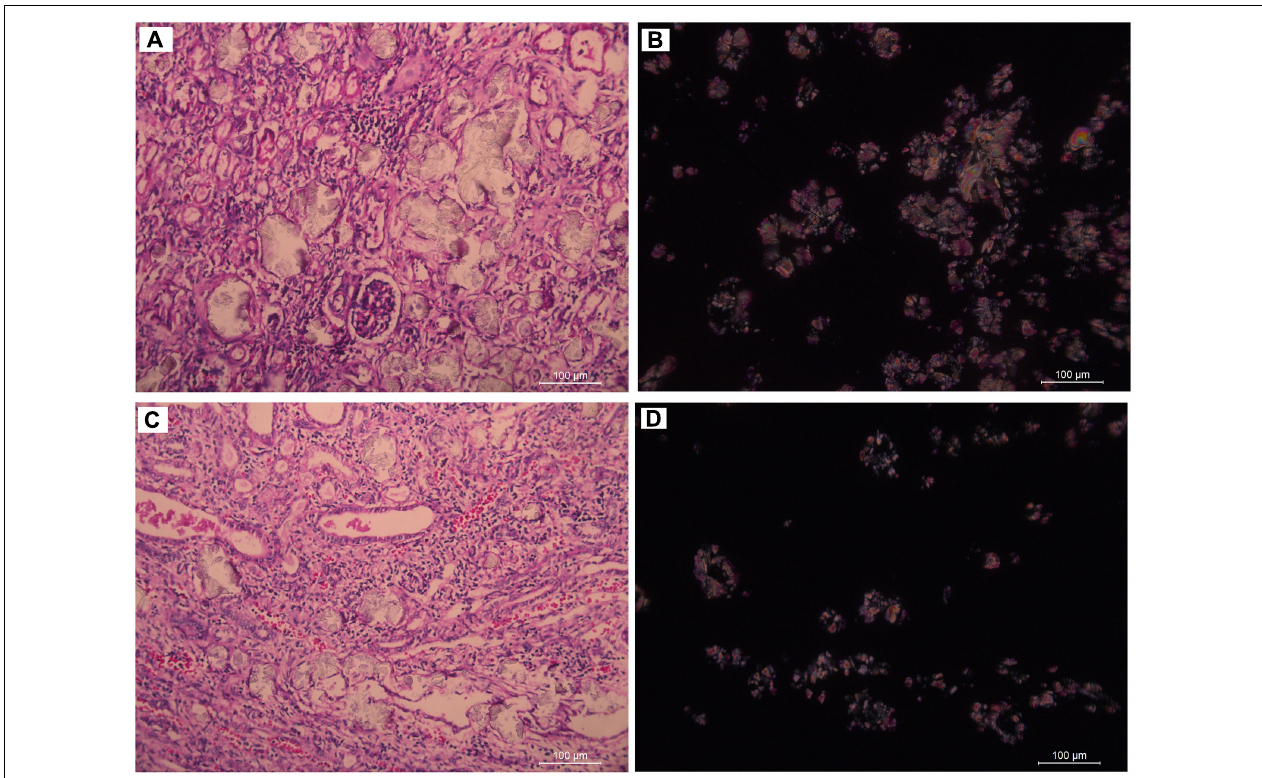
FIGURE 3 | Renal tissue of III:4 viewed under the polariscope. (A,B) medullary nephrocalcinosis, (C,D) cortical nephrocalcinosis. (A,C) Under Single polarization (B,D) Under crossed nicols.